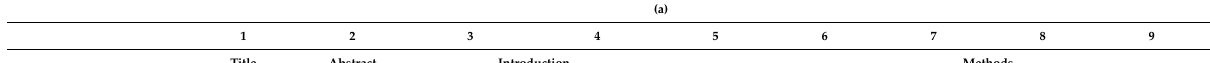
Table 4. Quality assessment of animal intervention studies following the ARRIVE guidelines.